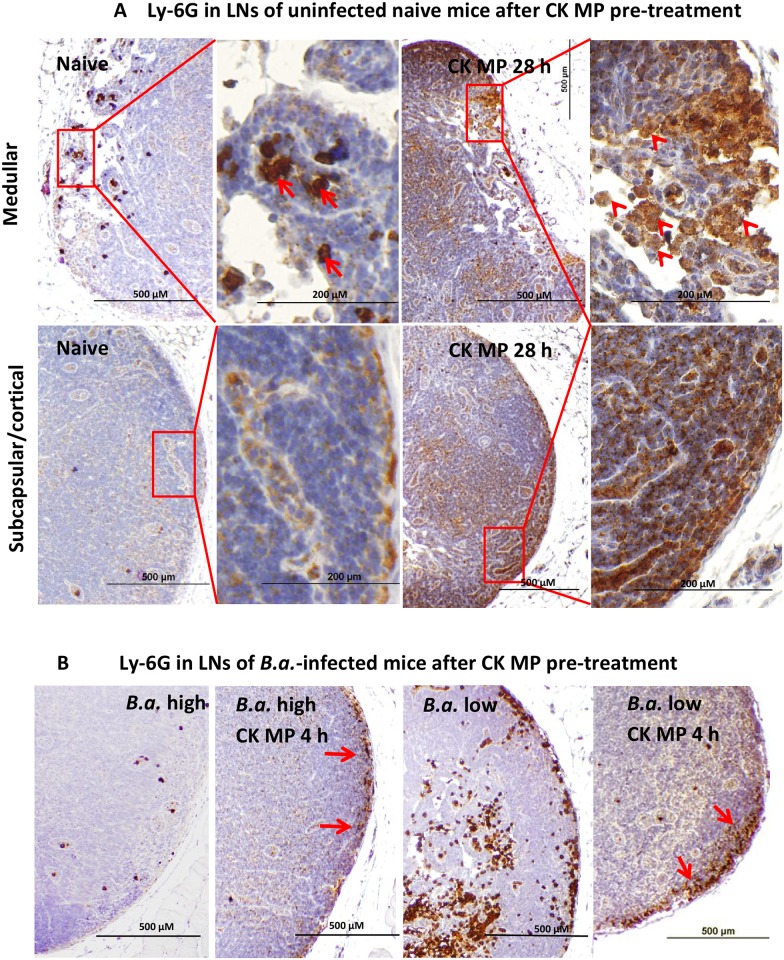
Administration of CK-loaded MPs results in the increased appearance and altered distribution of the neutrophil-specific antigen Ly-6G in the popliteal LNs of naïve and B.a.-infected mice.(A) Mice were injected into footpads with CK-loaded MPs (CK MPs) for 28 h and the presence of Ly-6G+ cells was revealed immunohistochemically (brown color) using primary antibody against Ly-6G. The medullar (A, top row) and subcapsular/cortical LN regions demonstrate change in the neutrophil antigen distribution pattern in response to CKs. The magnified squared regions in the right panels show the cell stained with high and low intensities (shown by arrows and arrowheads, respectively). The cortical LN regions from the CK-treated mice (A, bottom row) contain a large amount of diffusely-distributed Ly-6G antigen with a pattern shown in the magnified squared region in the right panel. (B) Mice were injected into footpads with CK-loaded MPs (CK MPs) for 4 h and then challenged with B.a. spores (low, 4x105 spores or high, 4x106 spores in 20 μl of PBS) for 24 h. The neutrophils were stained as in (A). The infection after CK administration resulted in the enhanced number of neutrophils in the subcapsular region (arrows). Low B.a. dose stimulated the neutrophil migration (B, middle right panel), but high dose abrogated it (B, left panel).